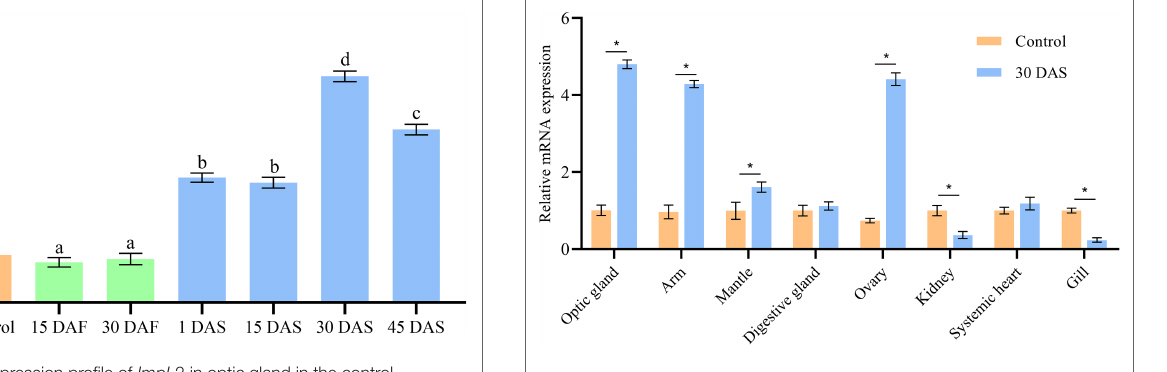
FIGURE 4 | Expression profile of ImpL 2 in different tissues in control group and senescence group (30 DAS). Data were normalized to the abundance of EF expressed in the same samples and are presented as the mean ± SD (n = 3). *p<0.05, independent t test. DAF, days after fasting; DAS, days after